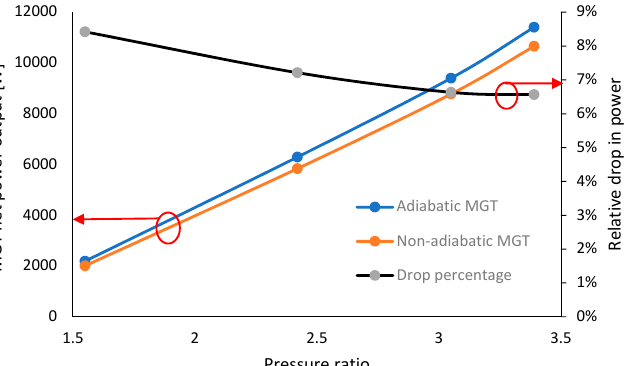
Figure 8. MGT net power output at different operating conditions considering an adiabatic and non-adiabatic run and the relative drop in power when considering heat transfer in the calculations.